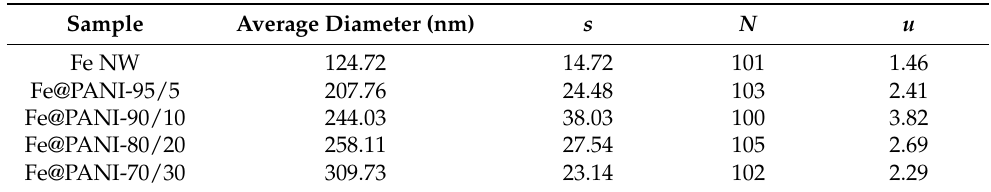
spline dotted curves are only to guide the eyes for the observation of the trend. Table 2. Summary of average diameter, standard deviation ( s ), number of input quantities ( N ), and standard uncertainty ( u ) for nanowires.